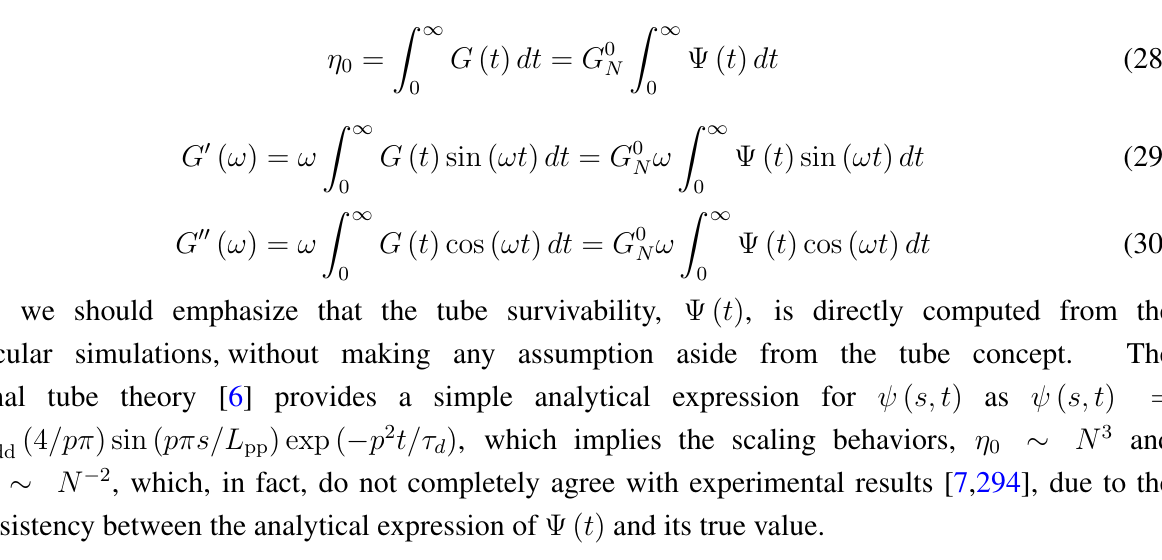
Figure 18. Reptation behavior of a polymer chain with contour length fluctuation (CLF) and constraint release (CR) effects. The dashed center line represents the original primitive path, while the solid red line represents the actual polymer chain, whose instantaneous primitive path is not specifically indicated. The CLF effect is associated with the variation of the primitive path length resulting from the retraction and subsequent expansion of the polymer chain within the tube. The CR effect is illustrated by the polymer’s lateral escape from the tube in ( c